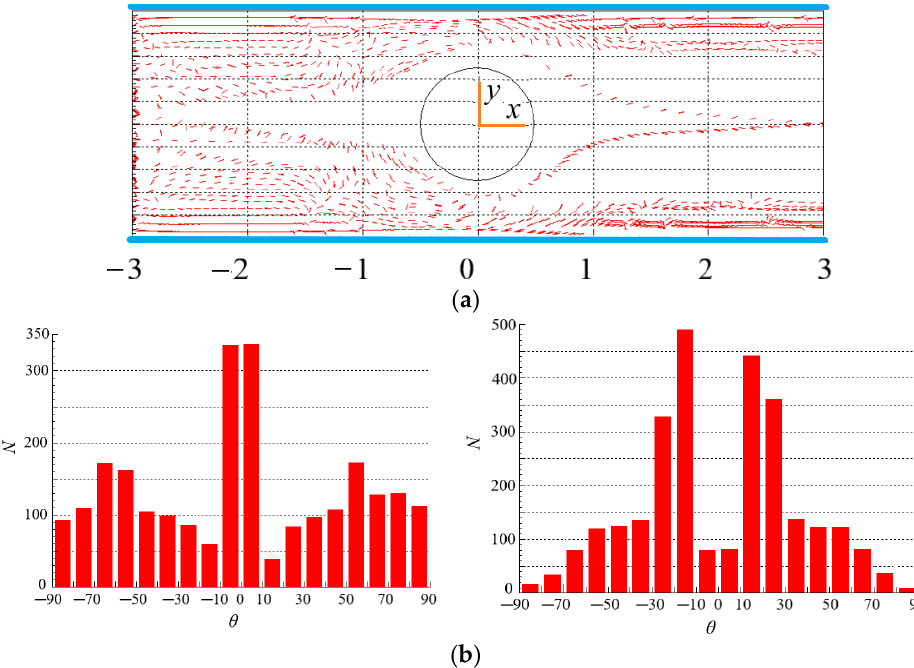
Figure 11. Spatial and orientation distributions of particles at β = 4 (Re = 2, n = 1.3). ( a ) spatial distribution. ( b ) orientation distribution: left: contraction flow ( x < 0); right: expansion flow ( x > 0).